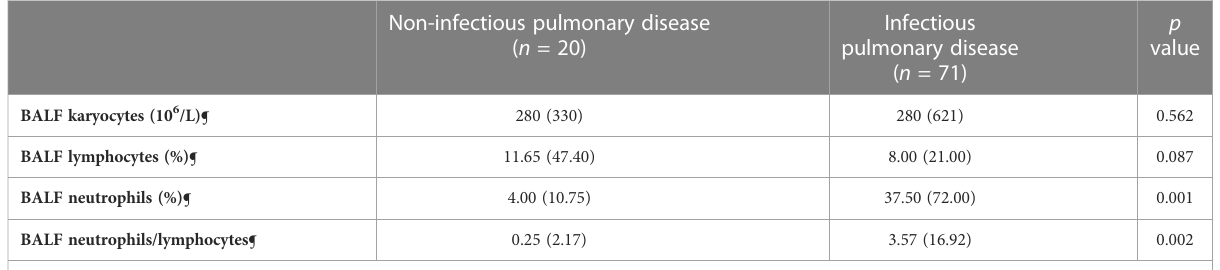
Statistical signi fi cance is indicated by bold font. BALF, bronchoalveolar lavage fl uid. ¶ Median (interquartile range).